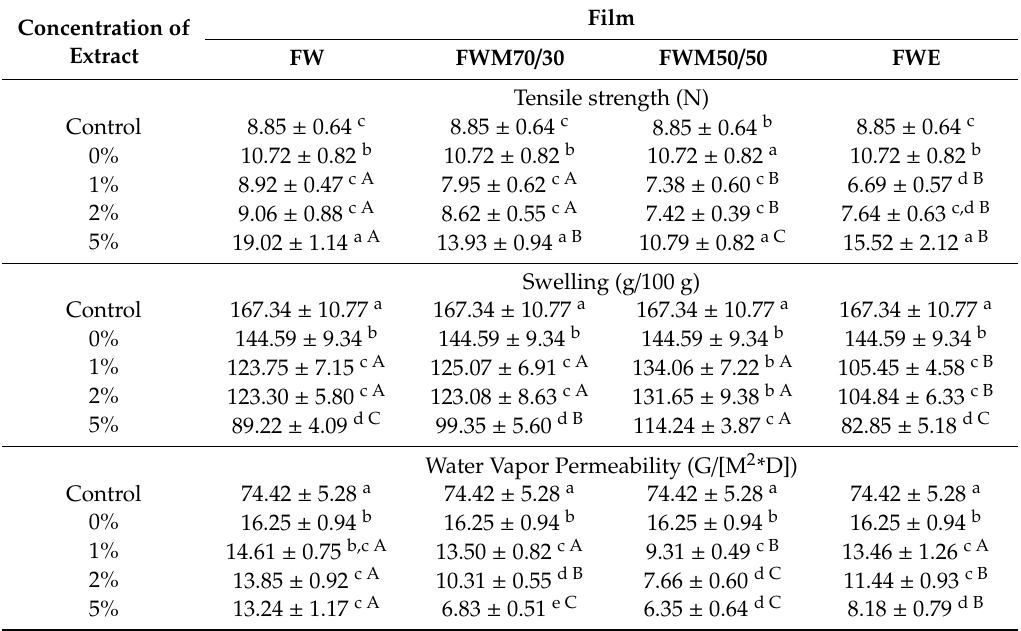
Table 7. Tensile strength, swelling, and water vapor permeability of starch films with chicory root extracts and phytic